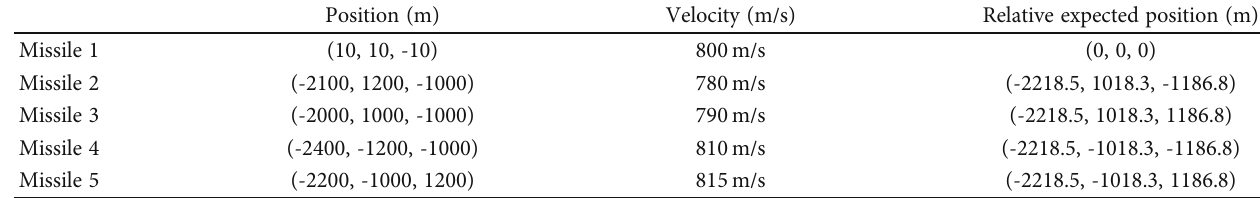
Table 1: Initial conditions of formation missiles.